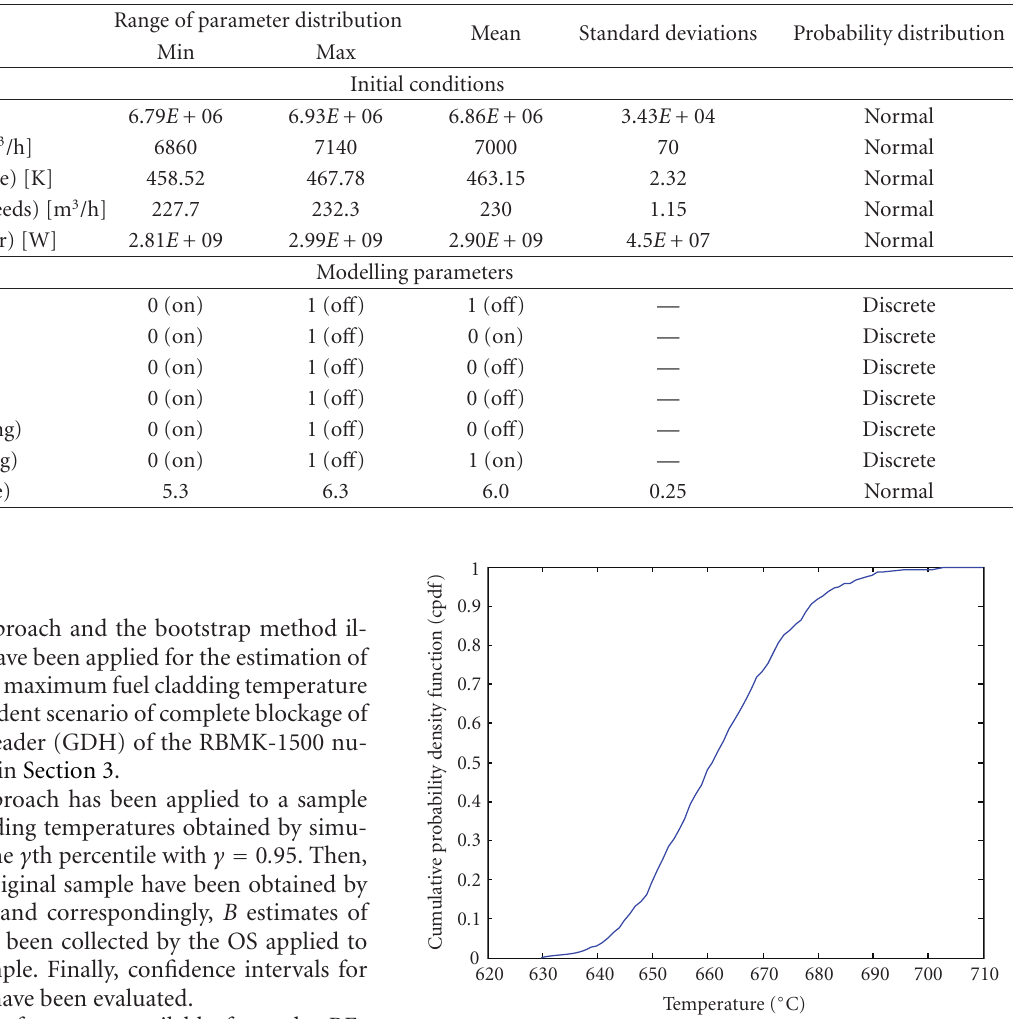
Figure 3: Empirical distribution function constructed from 480 RELAP5/MOD3.2